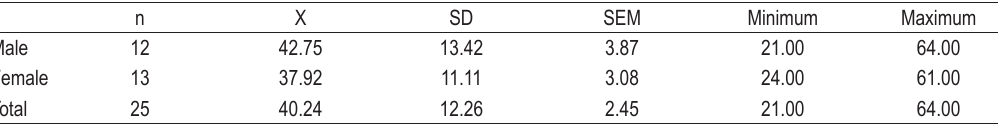
TABLE 1. Respondents’ structure by age